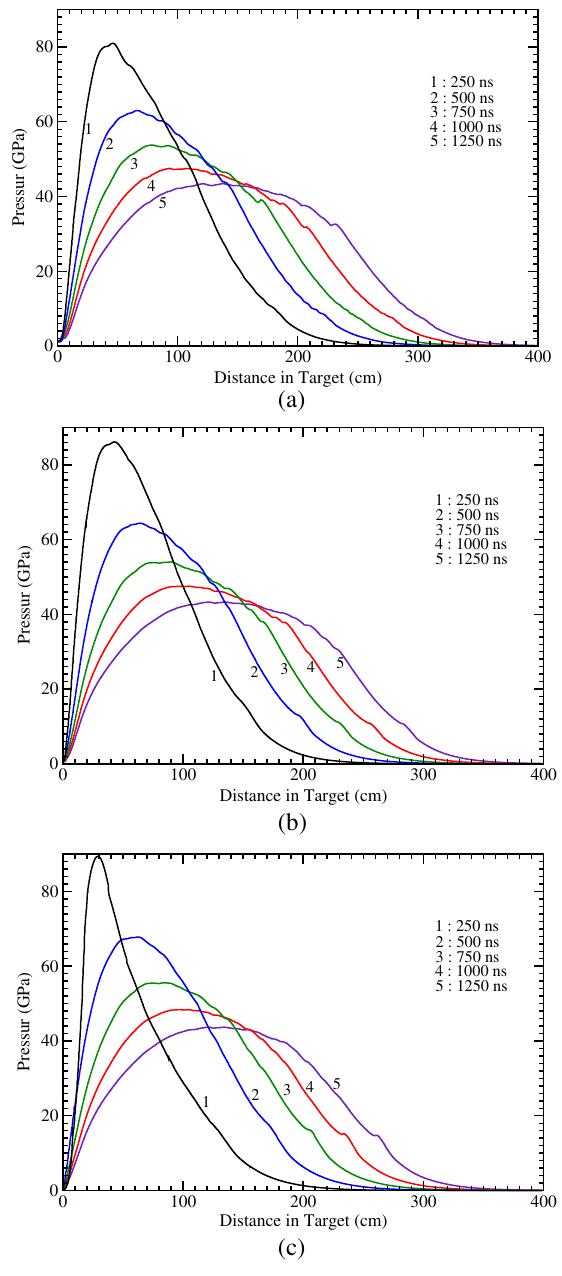
FIG. 8. Pressure profiles vs distance in the target at different times: (a) along the axis at r ¼ 0 , (b) at r ¼ 1 mm, and (c) at r ¼ 2